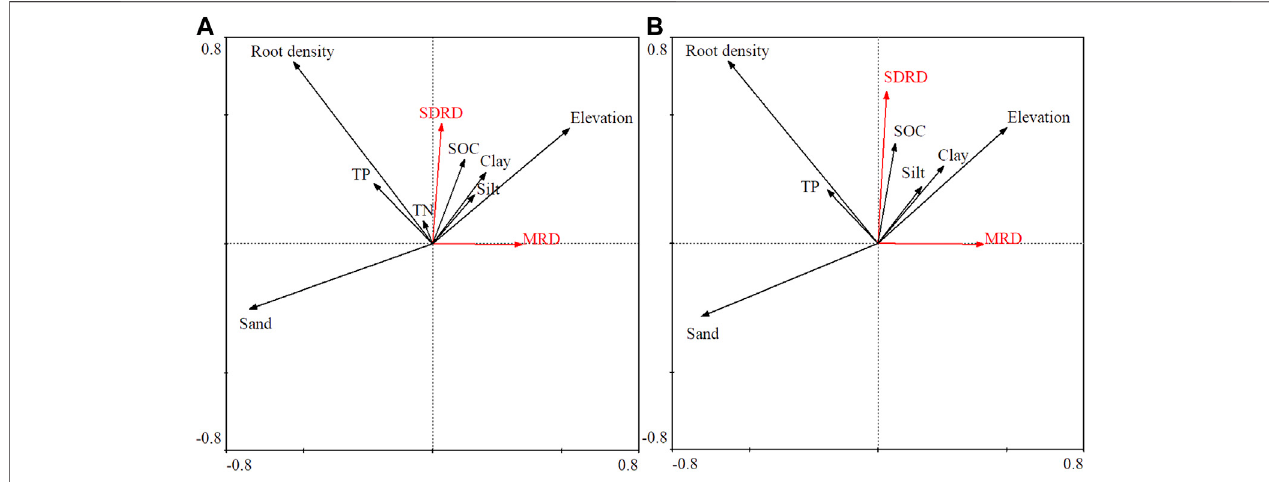
FIGURE 8 | Two dimensional ordination diagram of redundancy analysis of MRD and SDRD in (A) rainy season and (B) dry season.